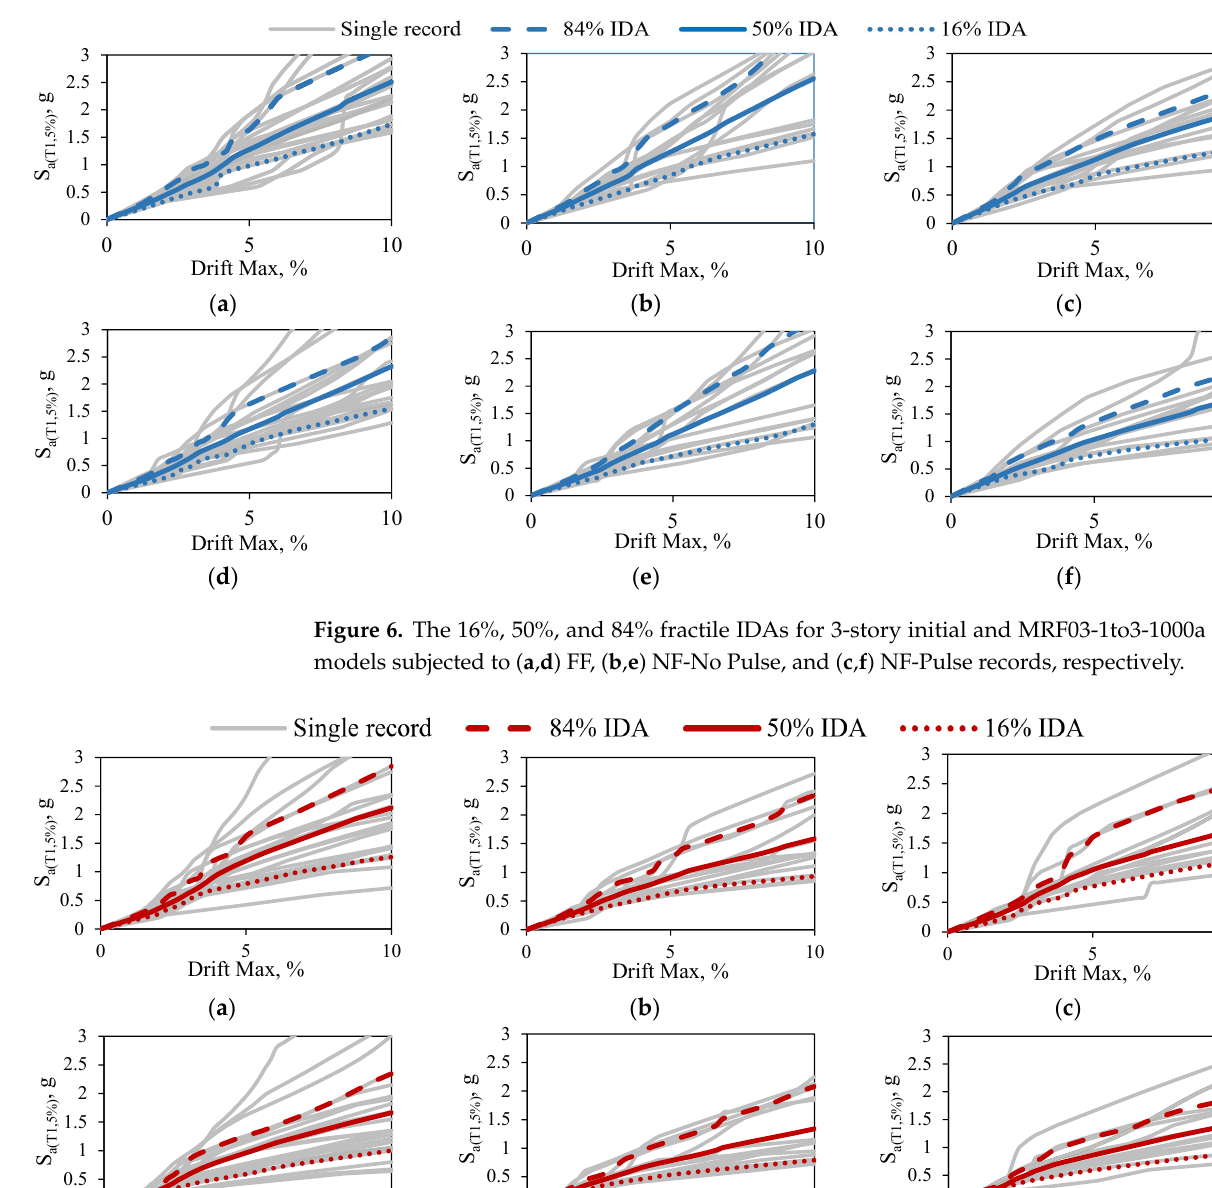
( f ) Figure 8. The 16%, 50%, and 84% fractile IDAs for 9-story initial and MRF09-1to9-1000a scenario models subjected to ( a , d ) FF, ( b , e ) NF-No Pulse, and ( c , f ) NF-Pulse records, respectively. Another common trend is the impact of FF records on 50% percentile IDA among identical models. The FF ground motions should be scaled up to marginally higher spec- tral intensities to reach collapse point, which indicates that near-field records have more devastating impacts on archetypes due to their high frequency content. This is more evi- dent in 3-story structures, especially in NF-Pulse records. Comparing the IDA fractile curves, it is observed that when S a is less than 0.5 g, the values of 16%, 50%, and 84% percentiles almost coincide, and post-fire condition has no noticeable effect on the struc- ture. However, as S a increases, the diversion between percentiles also amplifies, making the effect of fire clear and significant.